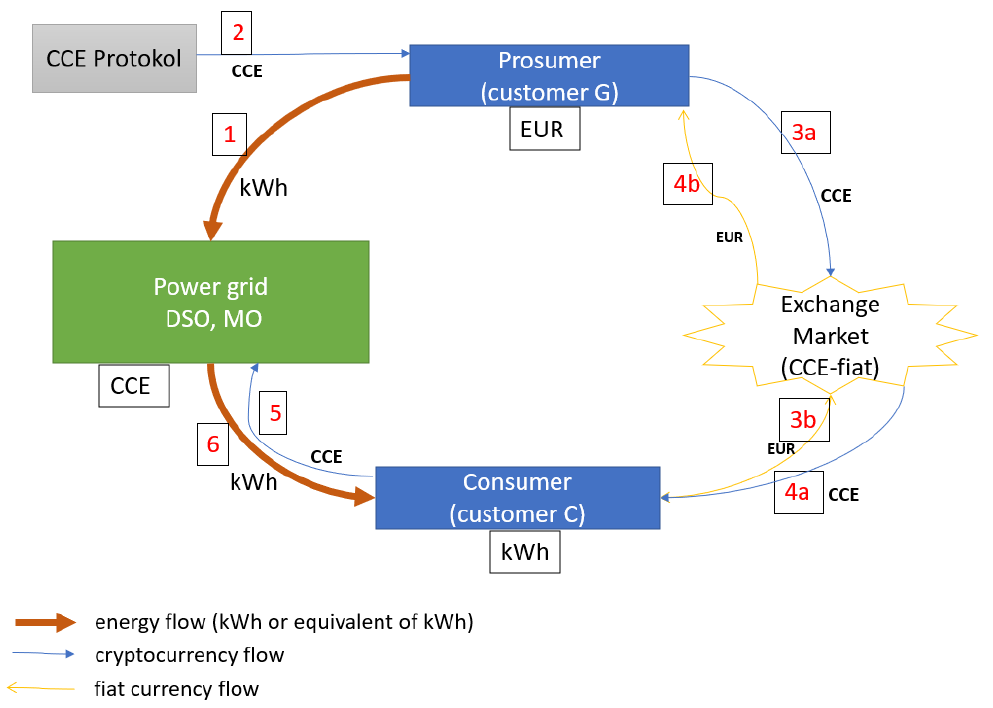
Figure 5. Flow chart of basic settlement operations in a CCE ‐ based concept. As a result of a full cycle of energy delivery through the network of the designated system between users, the C ‐ consumer has received the corresponding amount of energy (kWh), the prosumer delivering the energy has accumulated the corresponding value in fiat currency and the operator has accumulated the corresponding amount of CCE units. As the clearing system, the CCE–fiat exchange market and the network within the designated system (the number of users) develop, the structure will become more complex, new functional links between participants will be possible and complex participation strategies will be built. In particular, an operator could feed stored CCEs into the exchange market to increase momentary energy demand, reducing their price in fiat currency. Furthermore, the network operator’s operating costs could be covered by a mandatory subscription fee paid by all participants (G and C) connected to the network outside the CCE system. In this way, the operator would not have to speculate in the CCE exchange market to generate revenue. In this concept, an energy storage entity (including the dispatcher of the electric ve ‐ hicle) could participate. When taking energy from the grid, this entity would have the status of a consumer C and, when handing over, the status of a generator G. The profita ‐ bility of these activities would result from the respective strategy of the manager of this entity based on the detailed rules within the concept and the current price on the CCE–